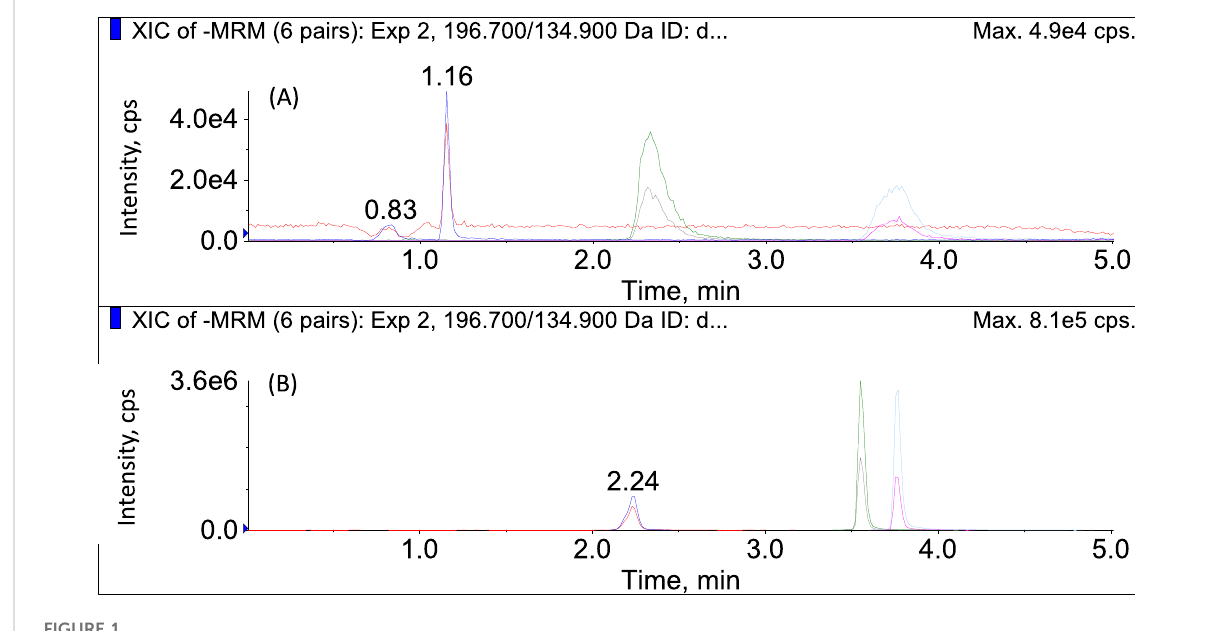
FIGURE 1 The chromatograms of salvianate A, rosmarinic acid, and salvianolic acid in MRM mode (A) before and (B) after the addition of formic acid in mobile